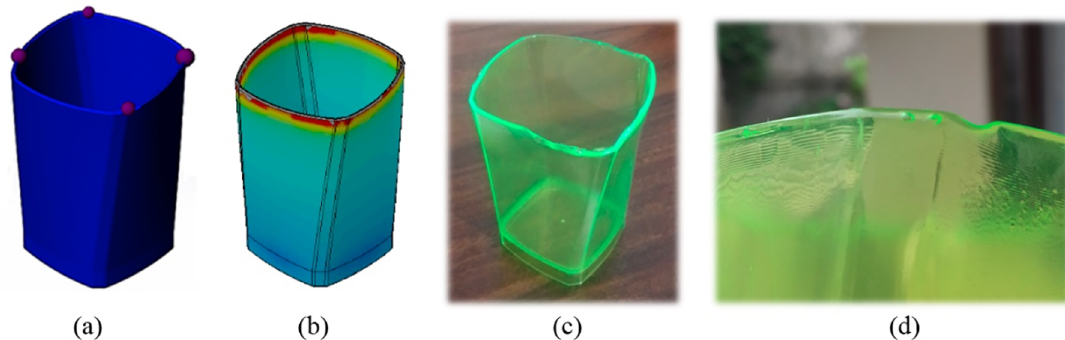
Figure 10. Identification of problems related to the air entrapment for an operational condition of 25 MPa for the injection pressure, 230 ºC for the injection temperature and 30 ºC for the mold temperature: a) location of the air trapped inside the mold cavities identified by the software; b) simulated incomplete filling of the mold; c) incomplete filling of the mold in the real situation; d) close view of the cup rim showing the lack of material due to incomplete mold filling and the presence air bubbles and